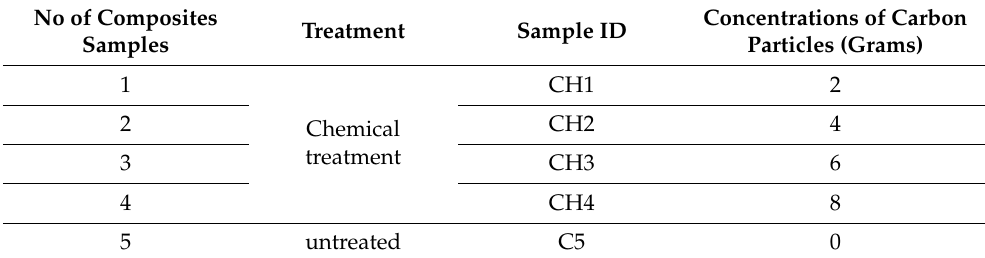
Table 1. Design of experiments.